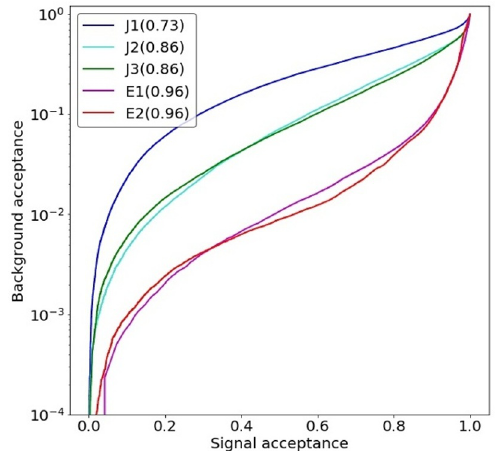
Figure 19 . ROC curves and their AUC for the binary classi(cid:12)ers to distinguish the (cid:23)(cid:23)h h from its background